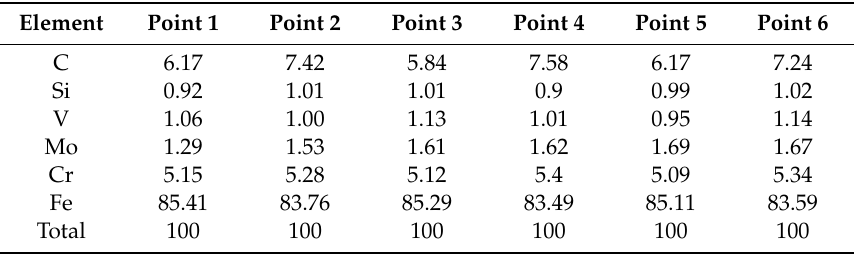
Table 4. EDS analysis, composition (wt %) of the tested points .